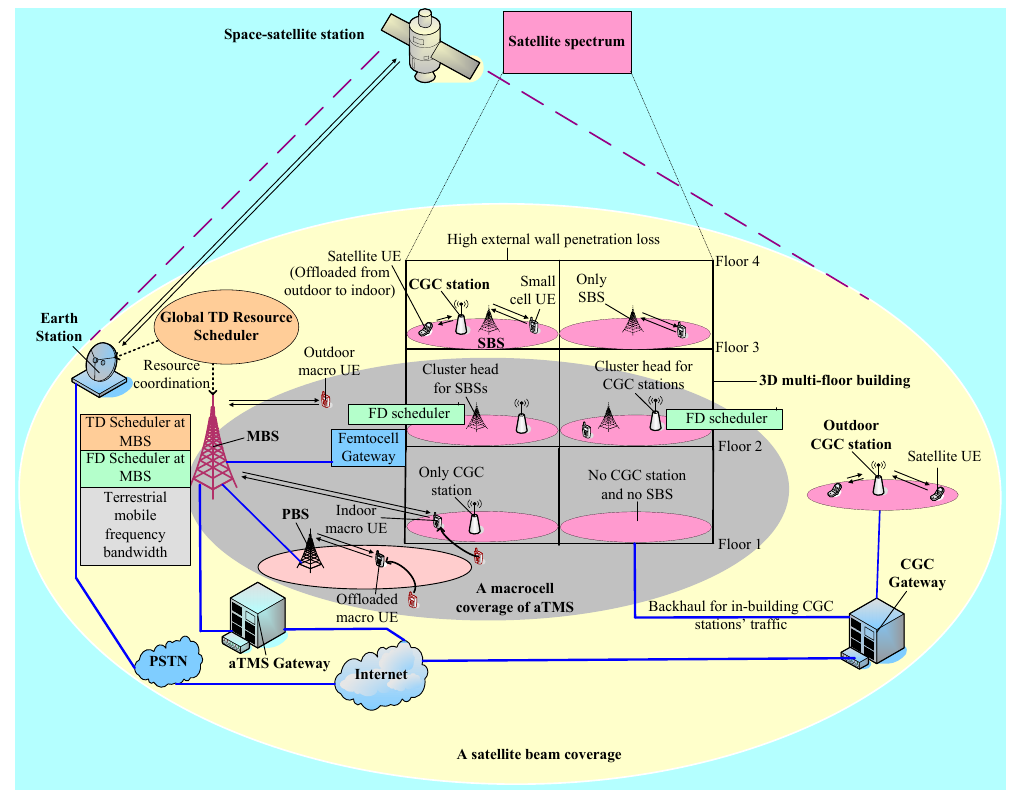
Figure 1. The system architecture of the proposed hybrid integrated satellite-mobile system and an autonomous terrestrial-mobile system (iSMS/aTMS) [22].